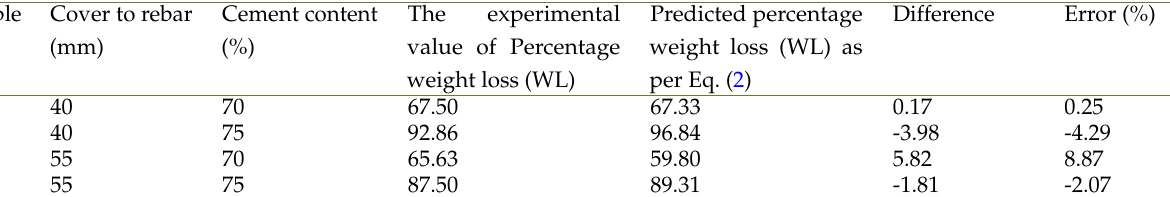
Table 7. Comparison of the experimental value of percentage weight loss of Hassan, et al.,